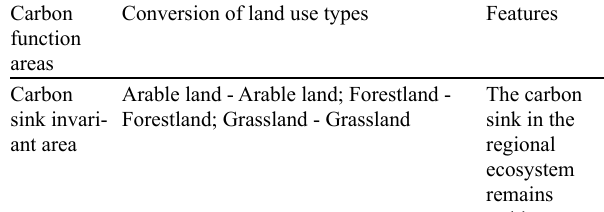
Table 1 Ecosystem carbon sink function areas in Pingshuo